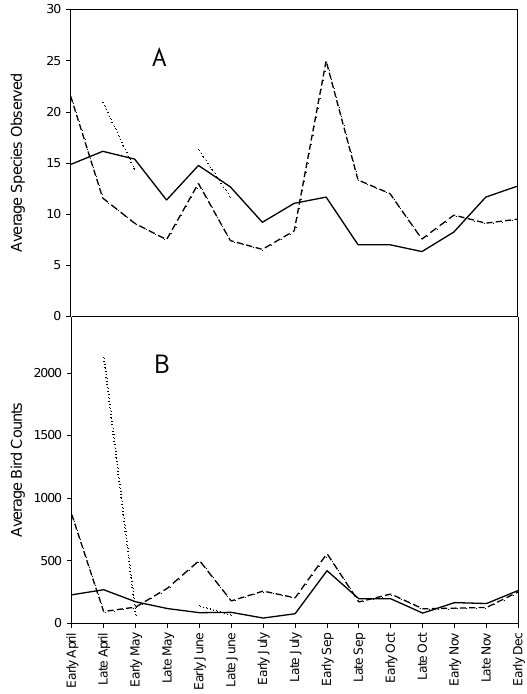
Figure 2. Average number of species and average number of individual birds observed per visit (wetland surveys) in the Sacramento (solid line), San Joaquin (dotted line) and Tulare (dashed line) sub-basins from April to December